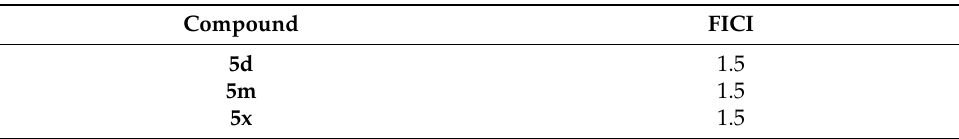
Table 2. FICI indexes of combinations of selected compounds with streptomycin.